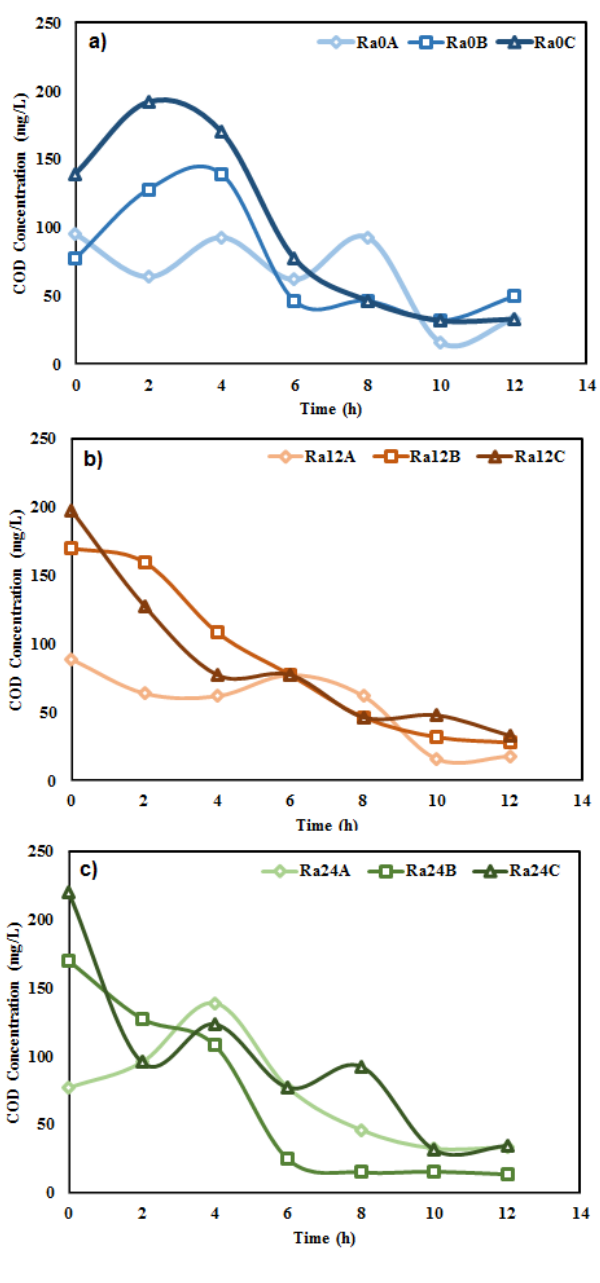
Fig. 2. Measured COD concentration at specified time for each